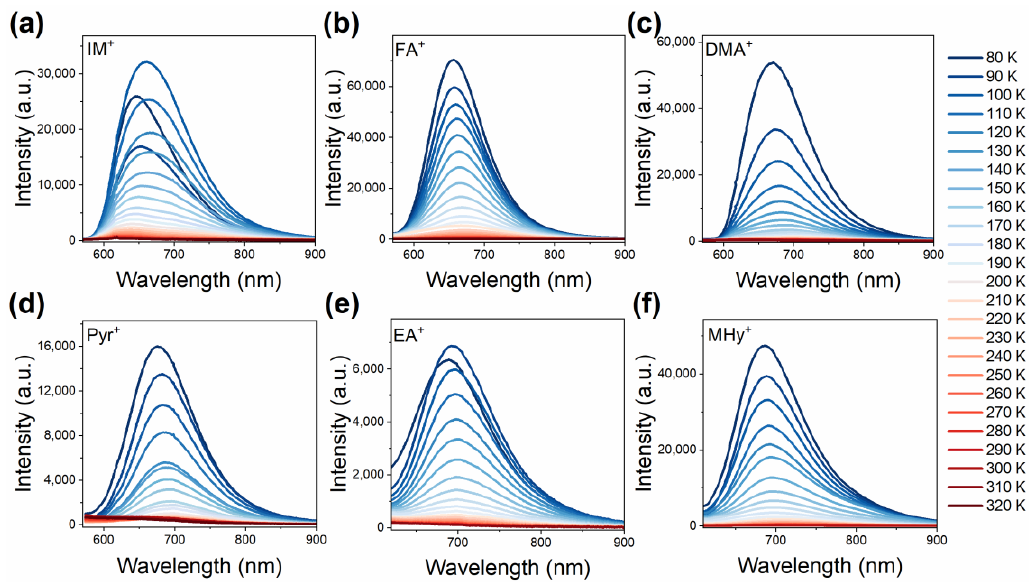
Figure 6. ( a – f ) Temperature-dependent emission spectra of the investigated manganese hypophos- phite perovskites.